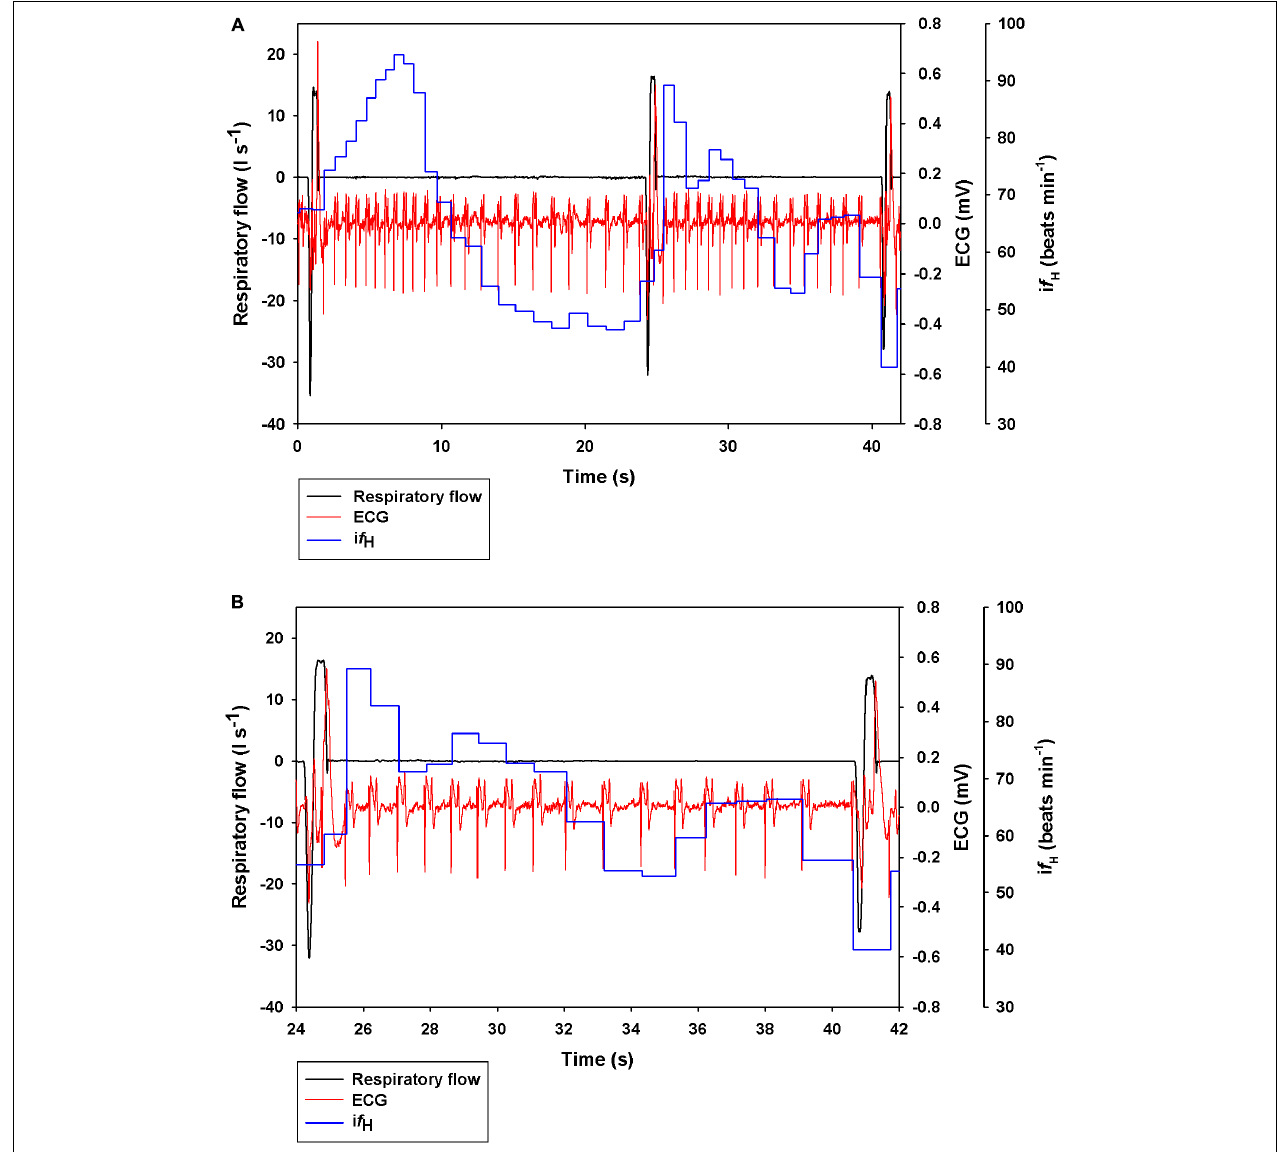
FIGURE 1 | Representative data showing respiratory flow, ECG, and instantaneous heart rate (i f H ) in a bottlenose dolphin during (A) 3 breaths, or (B) zoomed in for the 2nd breath.